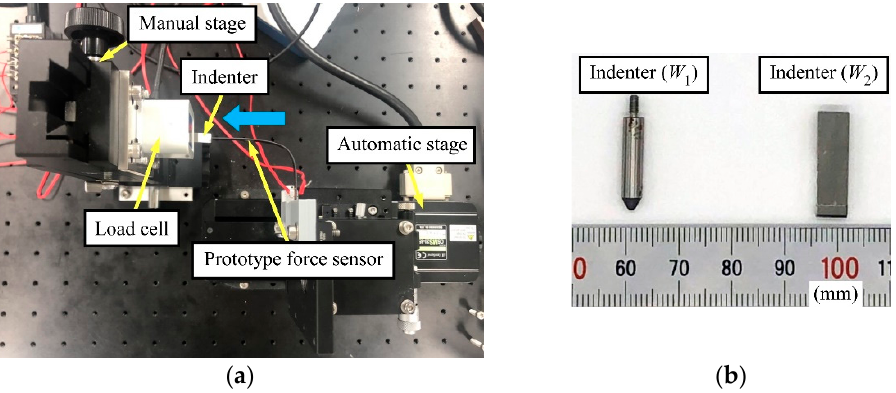
Figure 7. Appearance of ( a ) experimental apparatus (blue arrow shows sensor movement direction) and ( b ) indenters attached to load cell.